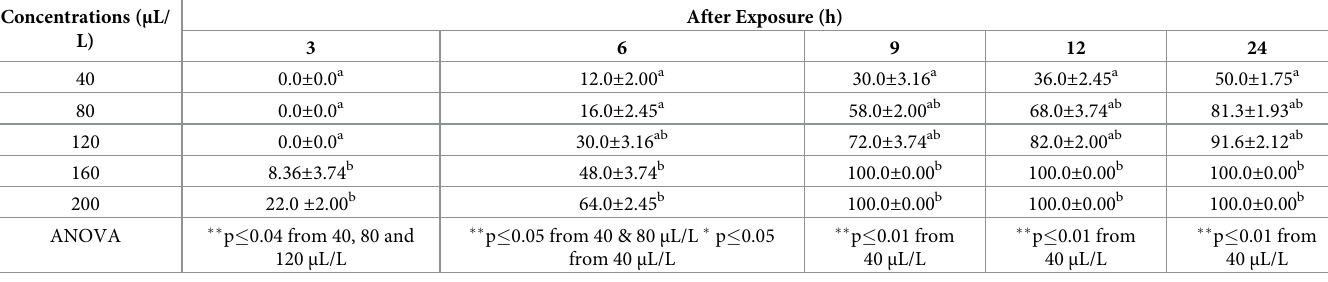
After Exposure (h)